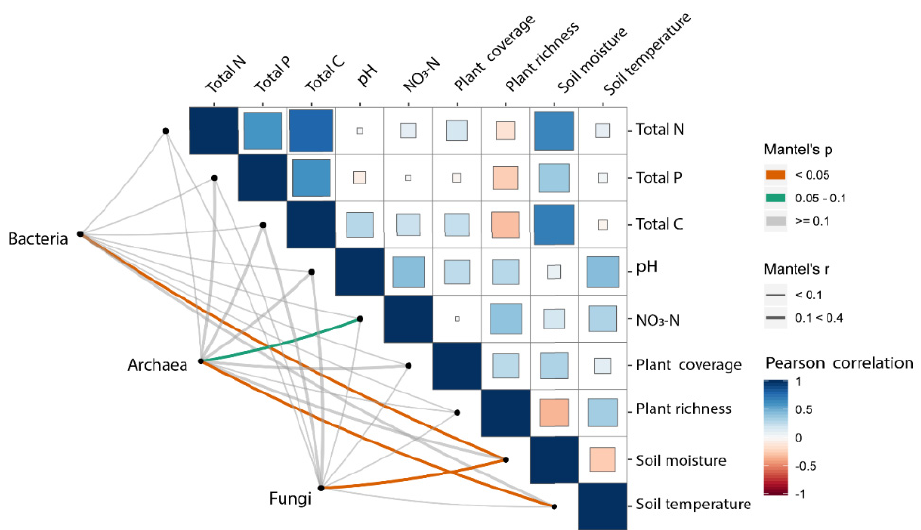
Figure 4. Mantel’s correlations between the environmental factors and bacterial, archaeal, and fungal